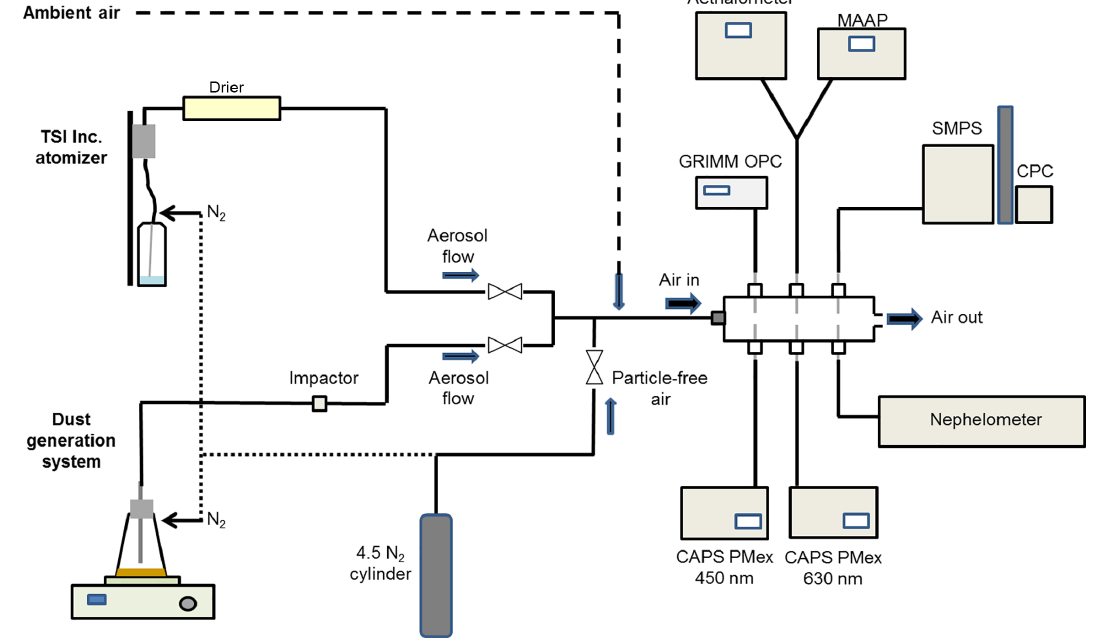
Figure 1. Experimental set-up used for the Aethalometer intercomparison experiments. Table 1. Specifications and references of instruments used during